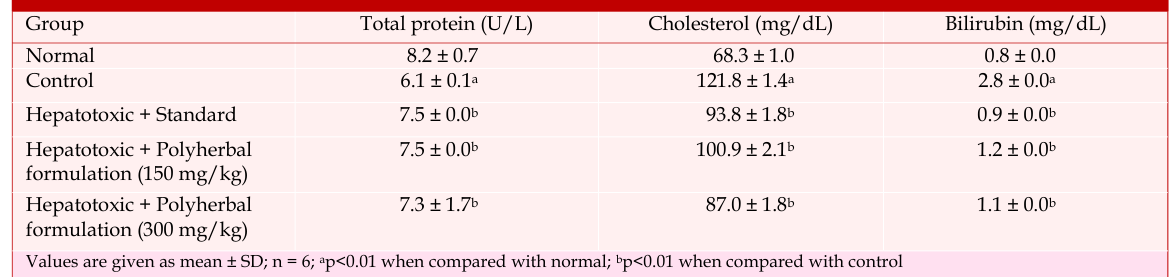
Effect of formulation on serum total protein, cholesterol and bilirubin levels in hepatotoxic rats